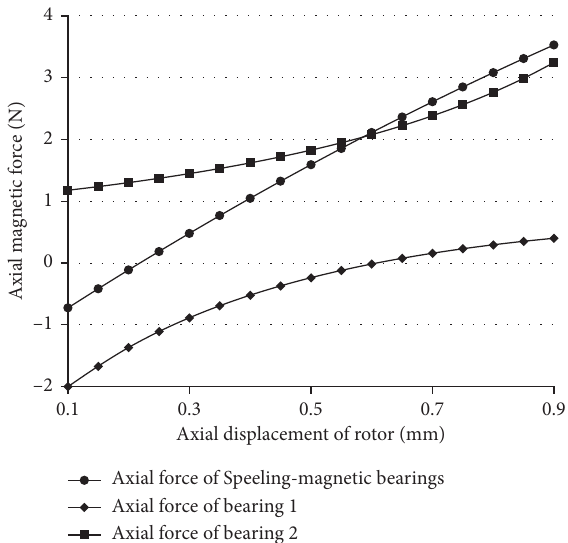
Figure 3: Schematic of the HD bearing in X-Y cross section